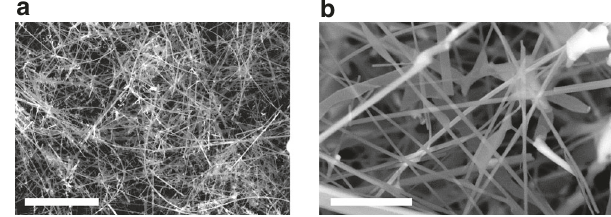
Fig. 1 SEM micrographs of typical Li 3 N nano fi bres (type I) at different magni fi cations. Images are taken at: a ×500 and b ×5000. Scale bars correspond to 50 μ m ( a ) and 5 μ m ( b